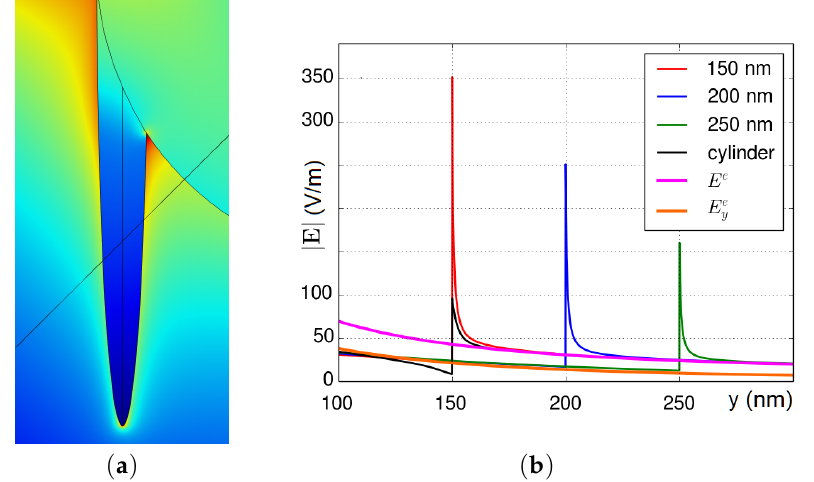
Figure 33. ( a ) scheme of a dielectric elliptical stick. The different parameters are available in [189]; ( b ) | E b ( y ) | corresponds to the field along the stick shaft for several lengths b . External E e -field and its tangent projection E e y in the absence of the stick are also displayed. Field peaks shows that the electrical field is confined in the nanovolume near the apex of the stick, reprinted figure with permission from [189]. Copyright (2017) by the American Physical Society.